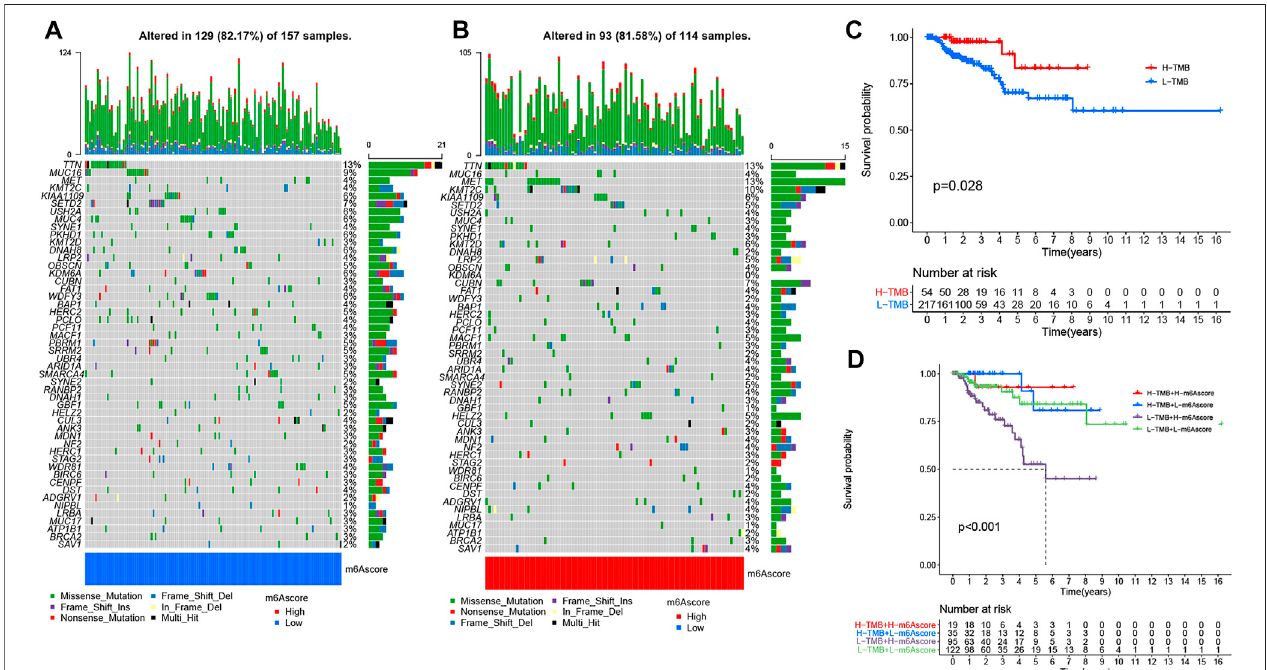
FIGURE 5 | The changes of somatic mutations among distinct m 6 A score groups. (A , B) Waterfall plot showing The changes of somatic mutations in (A) the low-m6A score set and (B) high-m6A score group. The bar plot at the upper part of the fi gure shows TMB. The numbers on the right part of the fi gure represent the mutationfrequency. (C) SurvivalanalysisfortheOSofpatients inhigh-and low-TMB groups. (D) K-Manalysisfor PRCCpatientsstrati fi edbyboth m 6 AscoreandTMB. MSI-H, high microsatellite instability; MSI-L, low microsatellite instability.